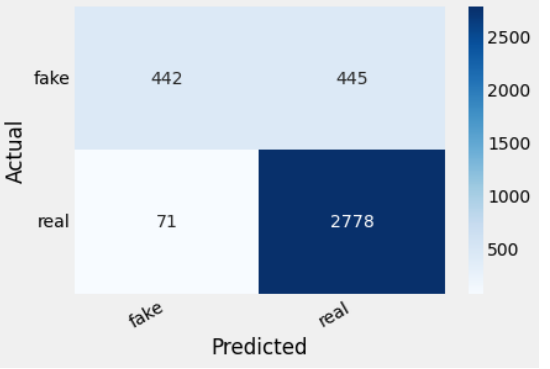
Figure 17. Confusion matrix of BERT base -CNN-BiGRU in GossipCop w/o user posting behavior features.